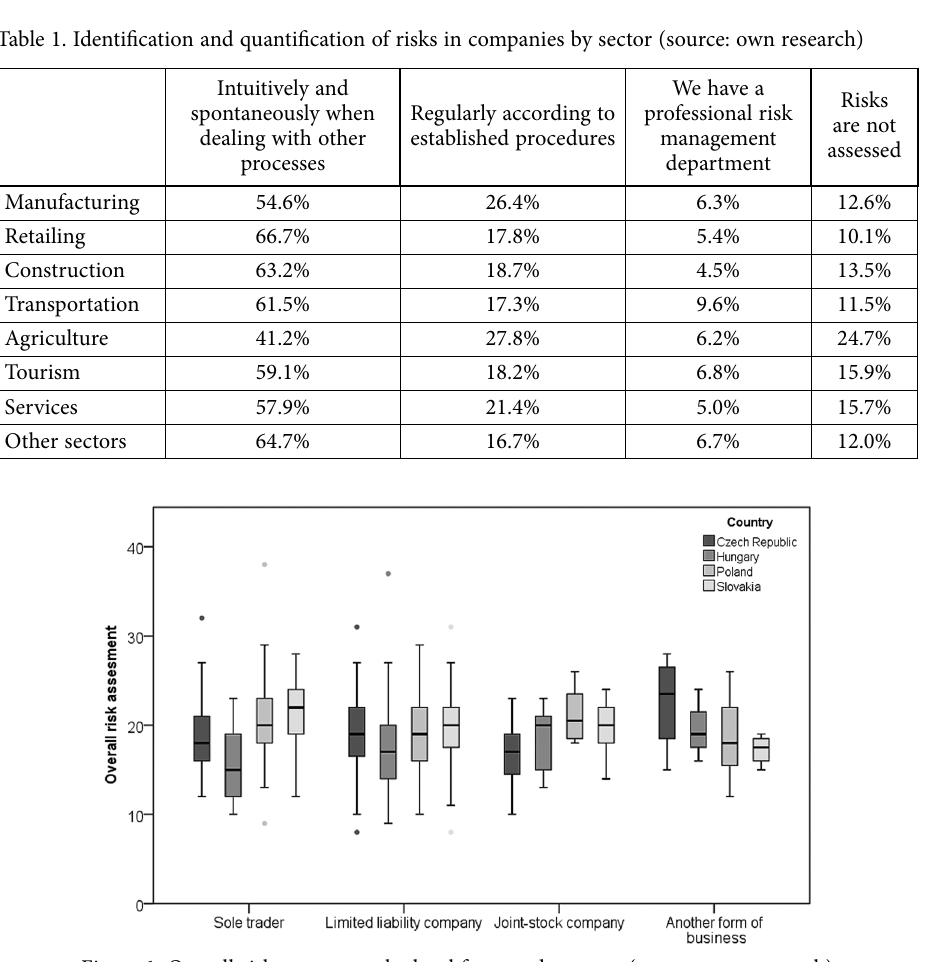
Figure 1. Overall risk assessment by legal form and country (source: own research)